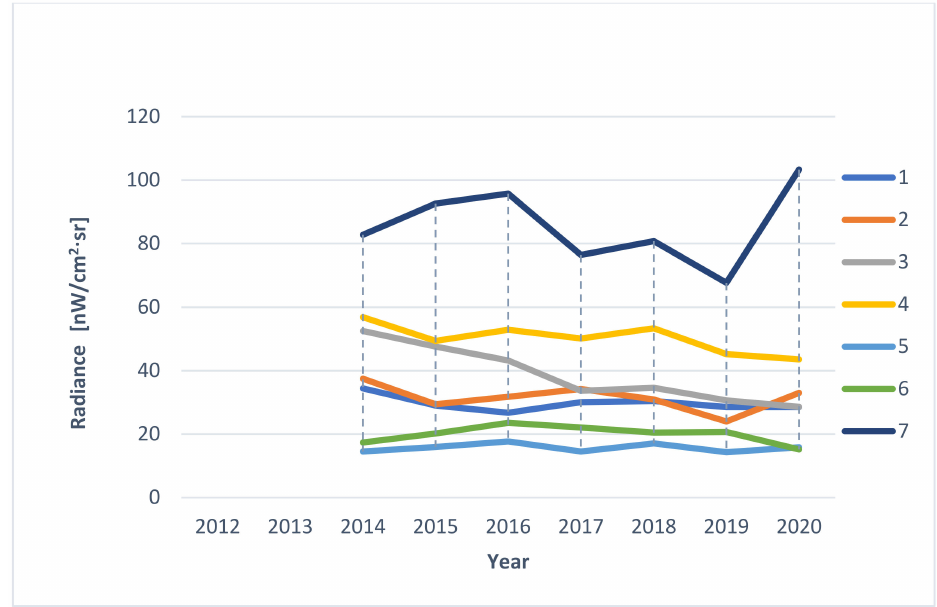
Figure 11. Radiance changes in 2014–2020 according to the service https://lighttrends.lightpollutionmap.info/ (accessed on 5 May